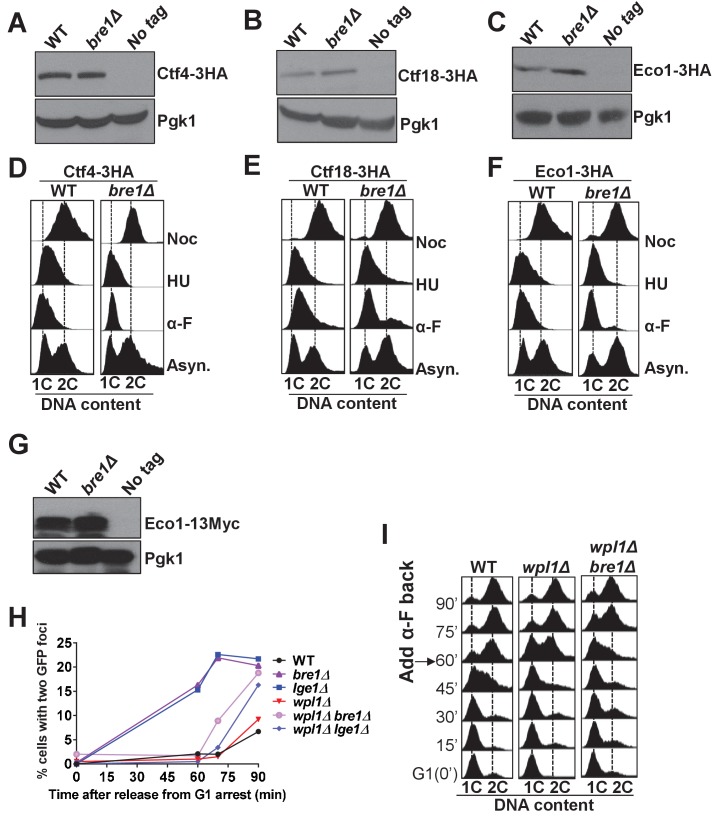
Bre1 is important for recruiting cohesion factors to replication origins.(A–C) Western blotting analysis of the protein level of Ctf4-3HA (A), Ctf18-3HA (B) and Eco1-3HA (C). Whole-cell extracts from early log phase WT and bre1Δ cells expressing the 3HA-tagged protein, and from the untagged WT strain were probed with anti-HA antibody. Pgk1 served as loading control. (D–F) Fluorescence-activated cell sorting (FACS) analysis of DNA content in WT and bre1Δ cells in Figure 3A & B, expressing Ctf4-3HA (D), Ctf18-3HA (E) and Eco1-3HA (F) arrested in G1, S and G2/M phases, respectively. (G) Western blotting analysis of the protein level of Eco1-13Myc. Whole-cell extracts from early log phase WT and bre1Δ cells expressing the 13Myc-tagged protein, and untagged WT strain were probed with anti-HA antibody. Pgk1 served as the loading control. (H) Analysis of sister chromatid cohesion in WT, bre1Δ, lge1Δ, wpl1Δ, and double-mutant strains wpl1Δ bre1Δ and wplΔ lge1Δ, by G1 arrest and release time-course assay. wpl1Δ have relatively low percentages of premature sister chromatid separation at 60, 75 and 90 min after release from G1, consistent with the study by Borges et al. (2013). bre1Δ and lge1Δ have elevated premature sister chromatid separation from 60 min onwards, consistent with Figure 1D and Figure 5C. Surprisingly, wpl1Δ partially rescues the bre1Δ or lge1Δ cohesion defect at 60 and 75 min, but not at 90 min. (I) Cell-cycle progression of WT, wpl1Δ and wpl1Δ bre1Δ used in Figure 3—figure supplement 2H. Cells were arrested in G1 by alpha-factor (α-F) for 3 hr. Cells were washed and released into YPD medium. α-F was added back to the culture at 60 min post G1 release to restrict cells in the next cell cycle at G1. Samples were collected every 15 min, and stained with propidium iodide for FACS analyses.